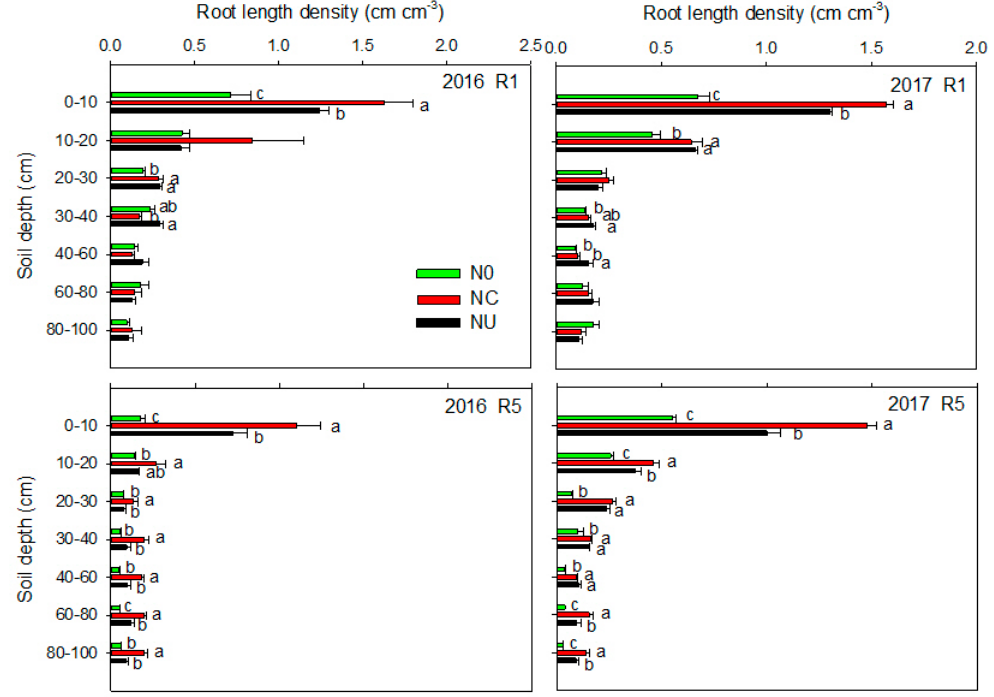
Figure 3. Root length density in the 0–100 cm soil layers with the three treatments in 2016 and 2017 as follows: no N application (N0), combined controlled release urea and normal urea at a ratio of 1:2 (NC), and normal urea alone (NU). Letters on the graph show significant differences at p < 0.05. Table 1. Effects of N application treatments on total root length density (cm cm − 3 ) in 0–60 (at six leaf stage (V6)) and 0–100 cm (at silking stage (R1), milking stage (R3), and dent stage (R5)) soil layers during the entire growing season in 2016 and 2017.